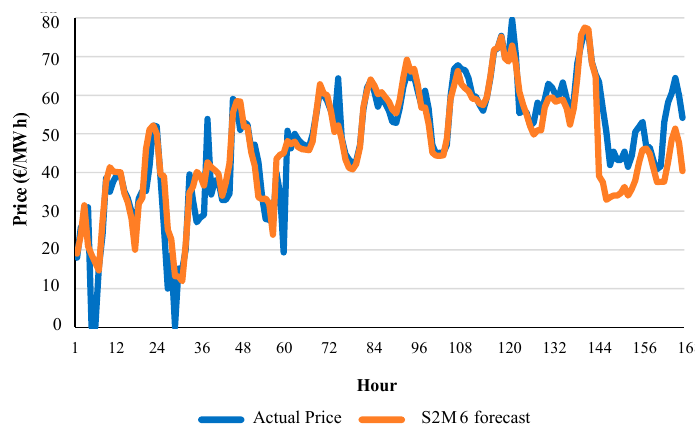
Figure 8. Actual price values and forecast values of model S2M6 of intraday session 2 for week 7 of year 2013.